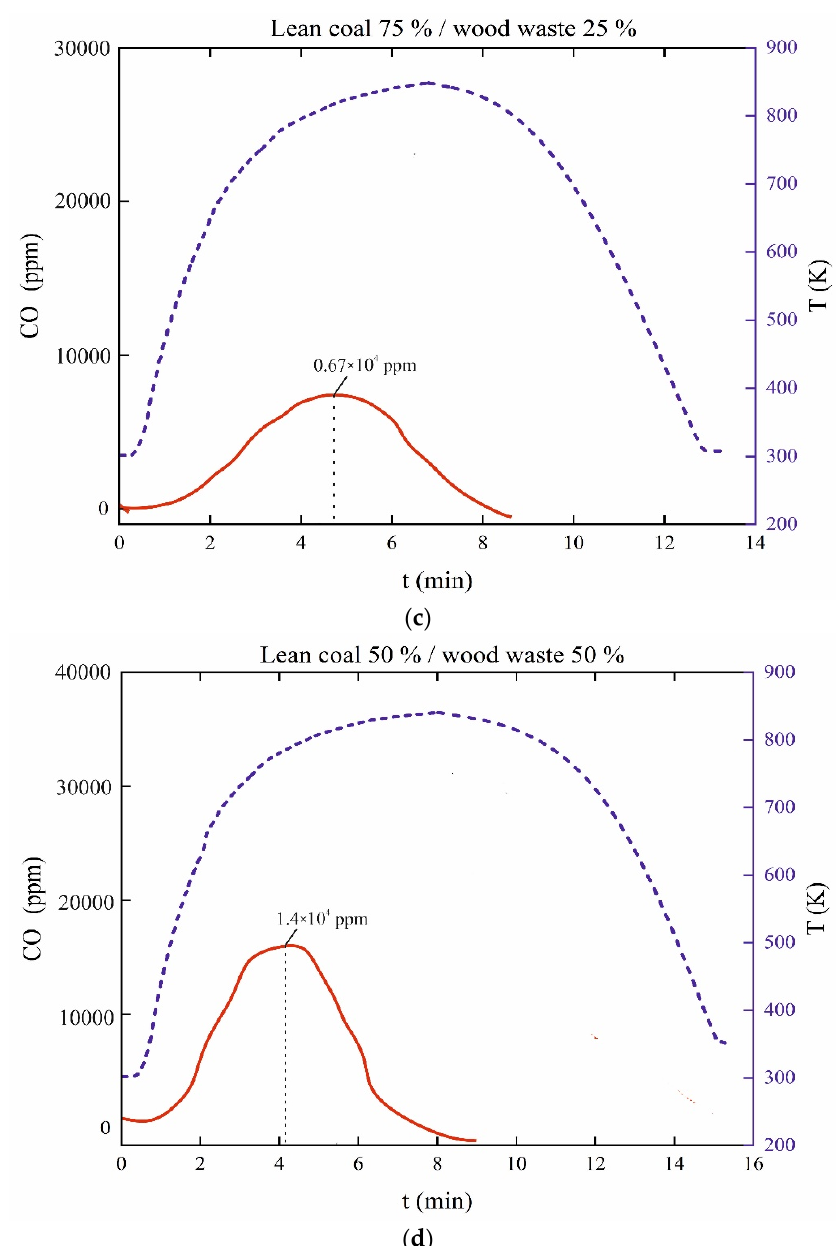
Figure 9. Changes in the concentration of carbon oxide in the gaseous products of the thermal decomposition of mixed fuels based on T-grade coal and wood with a change in the proportion of the latter in the mixture from 10% to 50%: ( a ) lean coal 100%; ( b ) lean coal 90%/wood waste 10%; ( c ) lean coal 75%/wood waste 25%; ( d ) lean coal 50%/wood waste 50%. Analysis of Figure 9 showed an increase in the carbon monoxide concentration. The to the calculated area under the same curve.